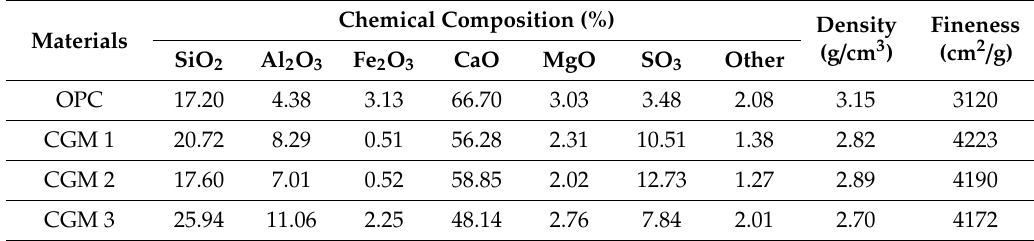
Table 2. Chemical composition and physical properties of used binders. OPC, ordinary Portland cement.